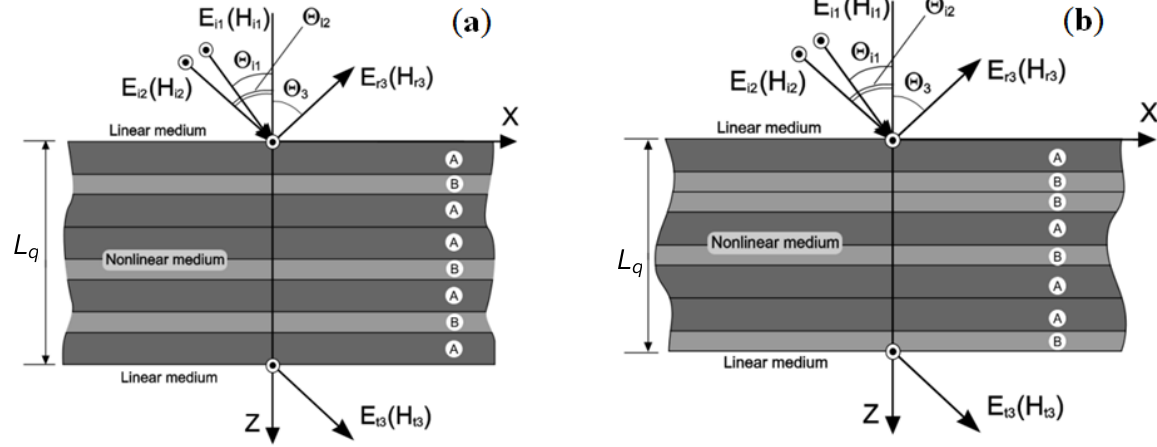
Figure 1. Geometry of the problem: ( a ) Fibonacci type QPS; ( b ) Thue-Morse type